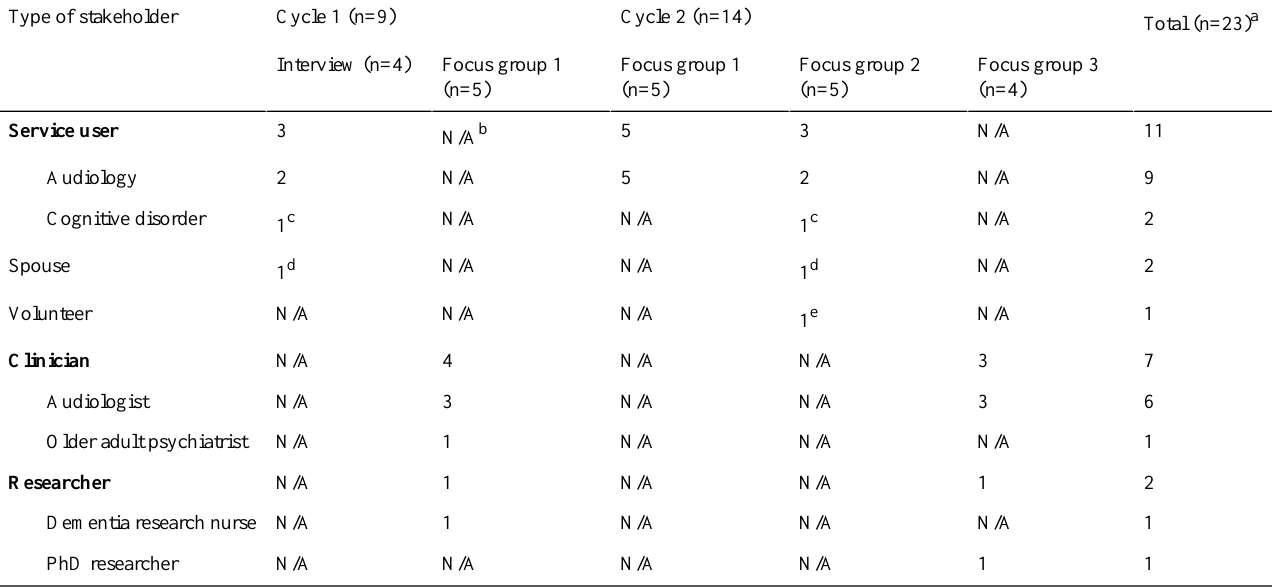
Table 1. Description of participating stakeholders across both